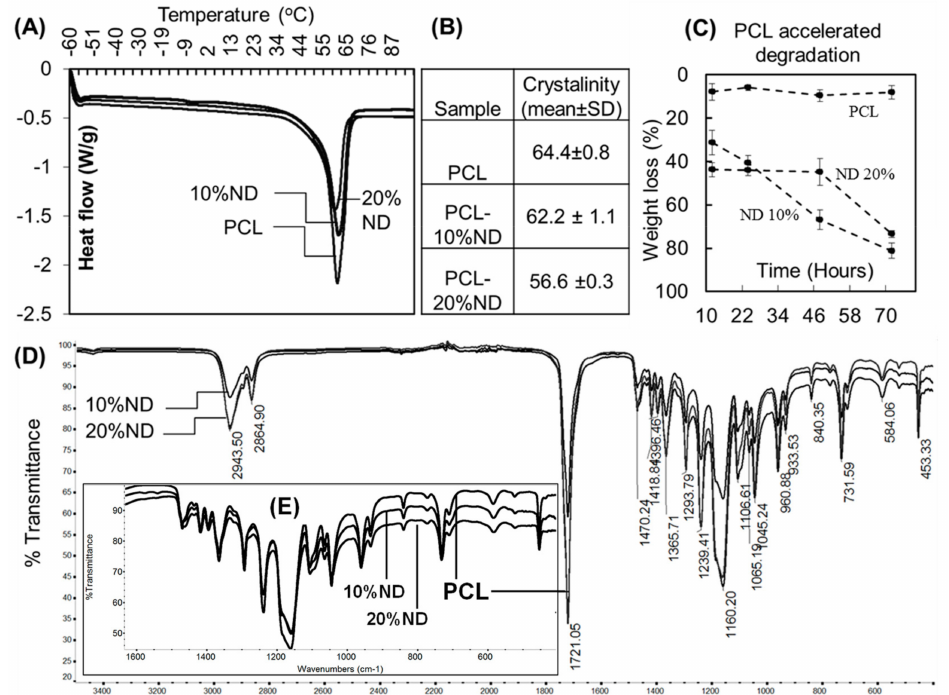
Figure 2. ( A , B ) Crystallinity of PCL and ND-PCL composites and their representative di ff erential scanning calorimetry (DSC) traces (n = 5). ( C ) Weight loss of samples in accelerated degradation experiments (n = 6). ( D ) Representative FTIR spectra of PCL and ND-PCL composites. ( E ) Inset showing FTIR spectra in the 400–1600 cm − 1 .